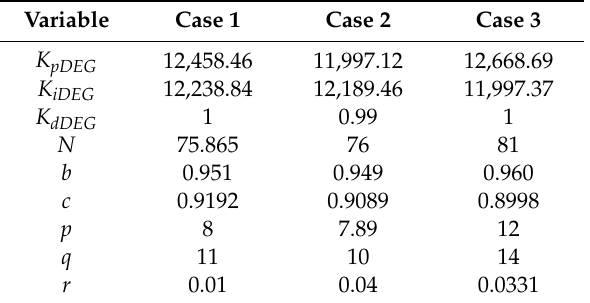
Table 8. Optimum 2DOF PID controller parameters after leveraging the FPA.